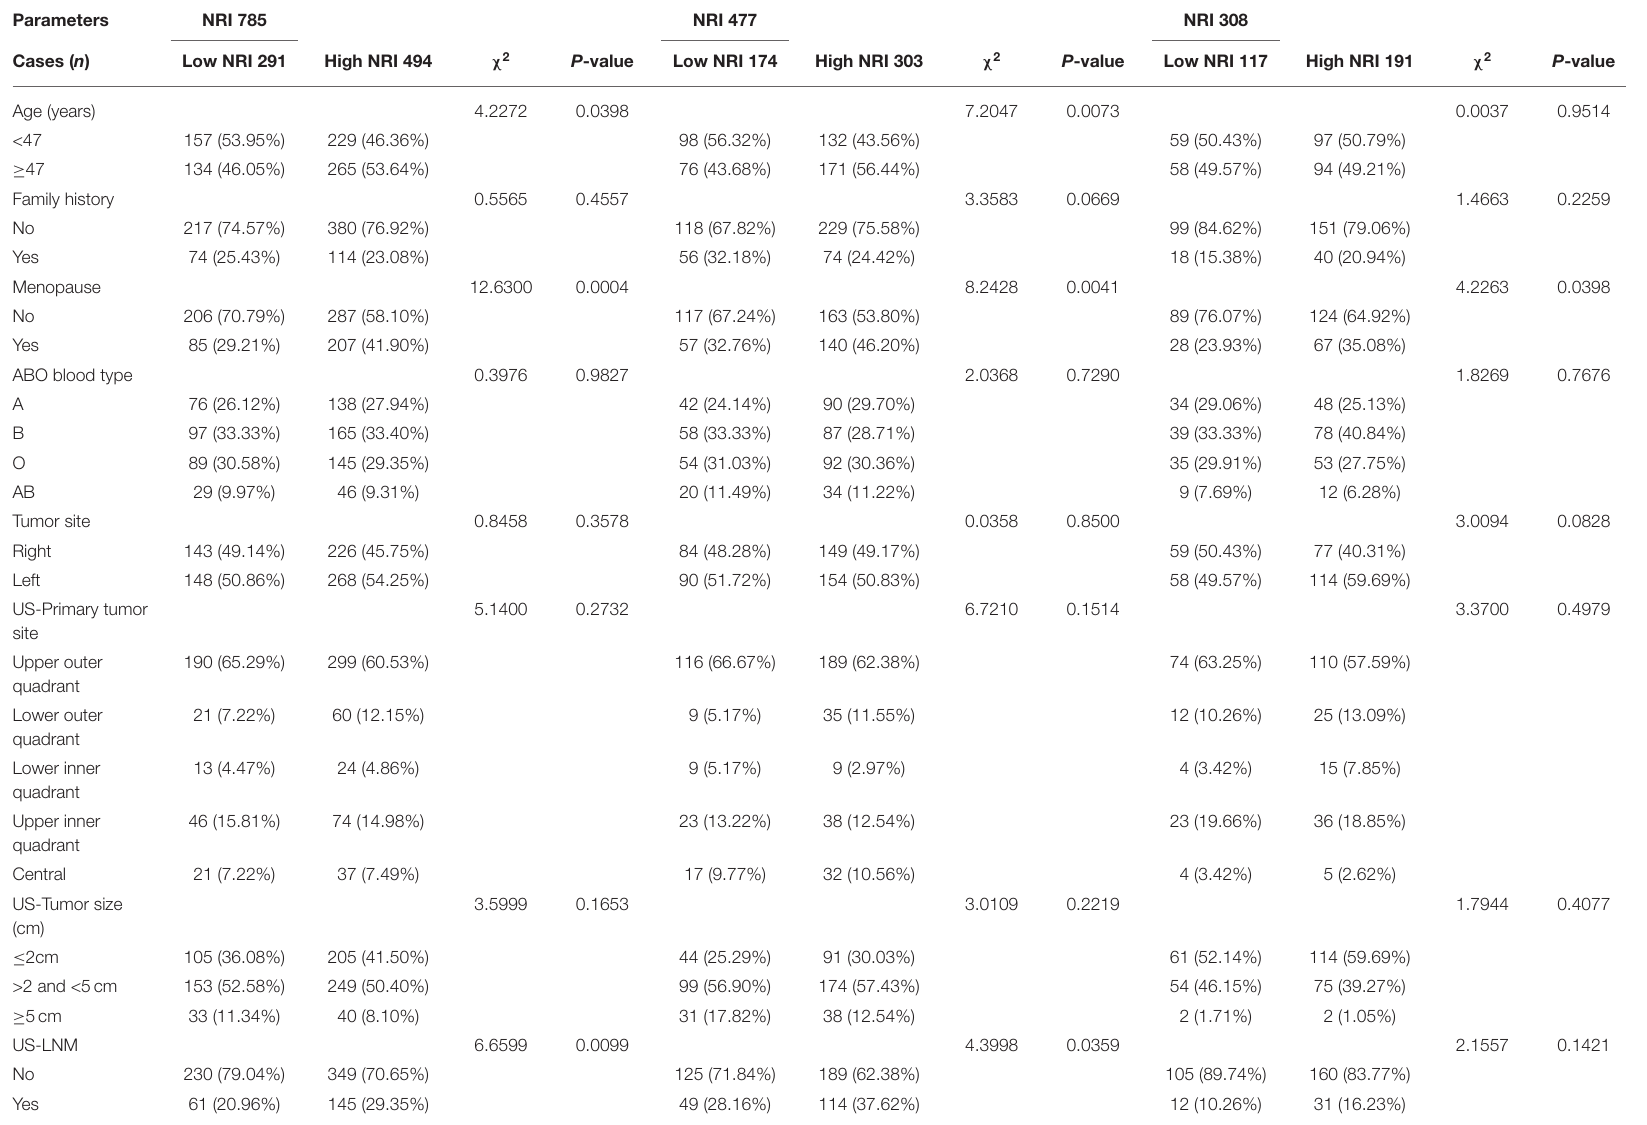
TABLE 1 | Demographic and clinicopathologic characteristics of the study’s 785 breast cancer